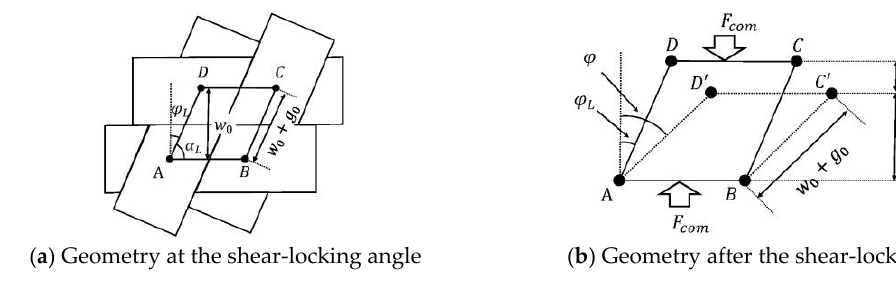
Figure 7. In-plane transverse compression of an RVE.